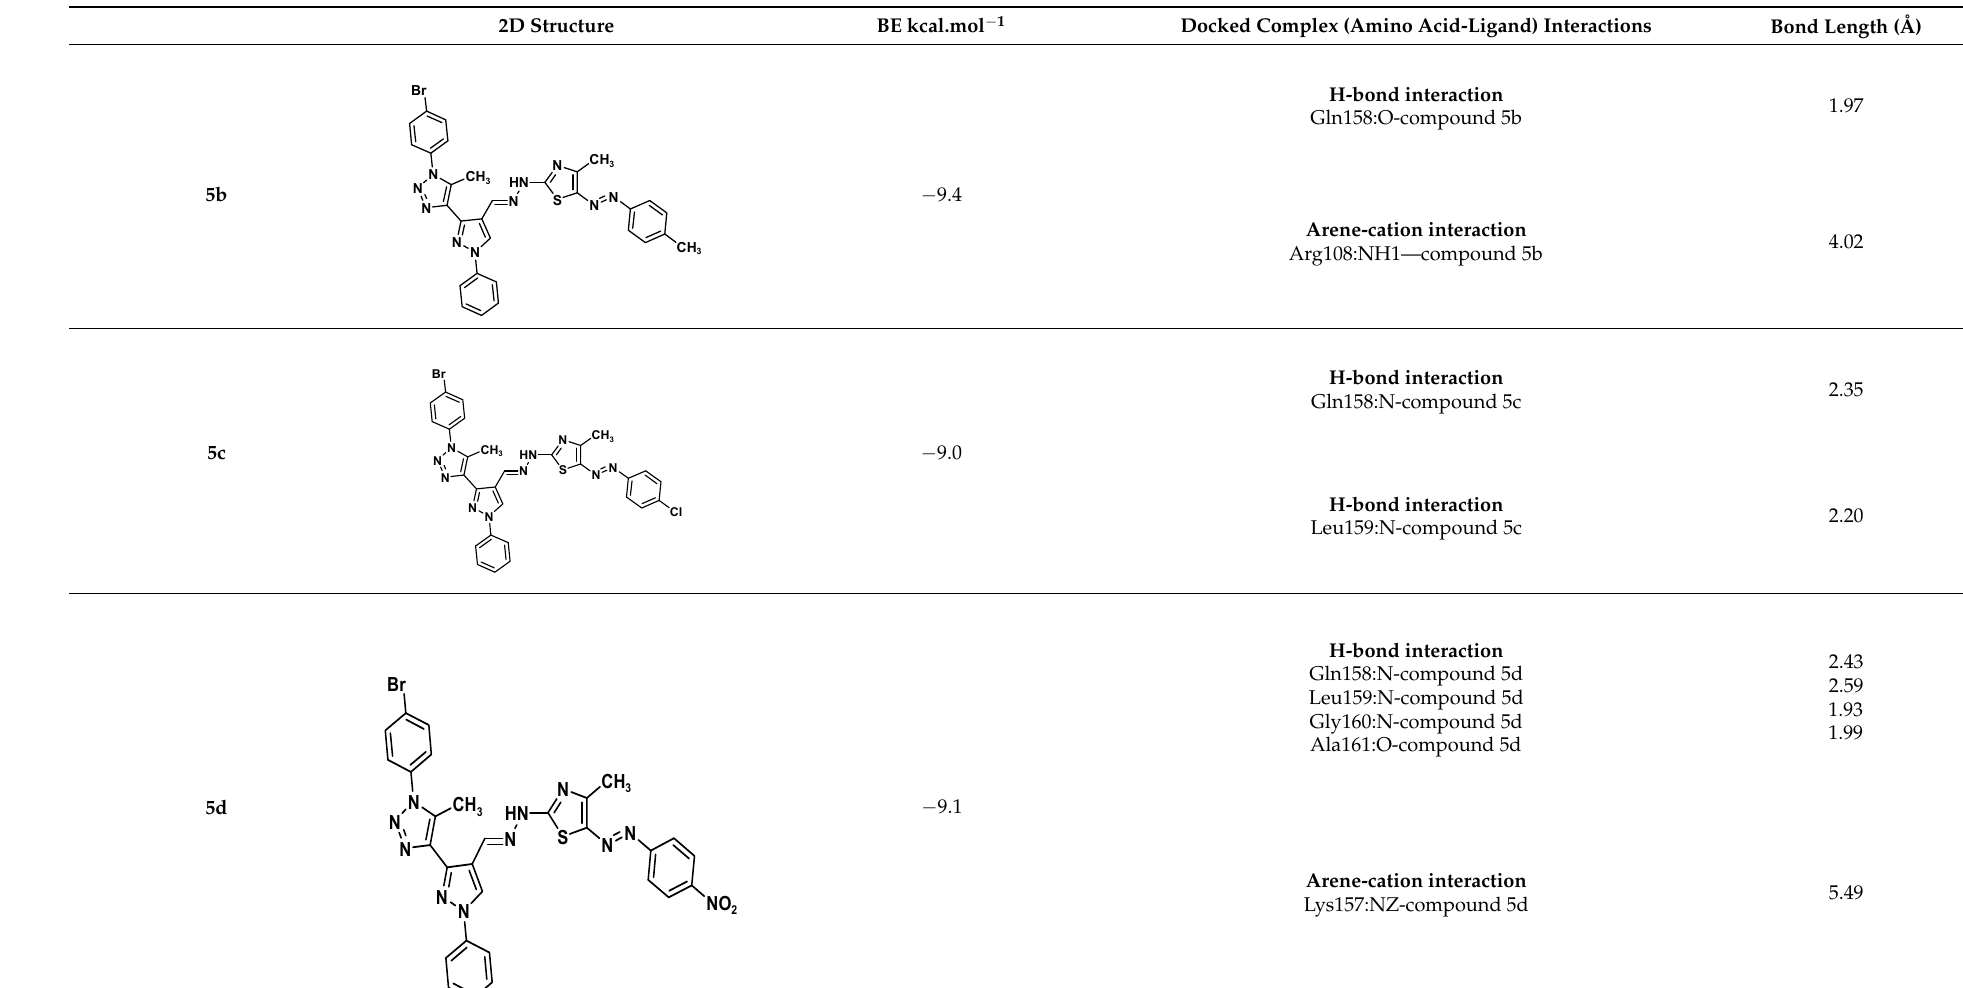
6 of 18 Table 1. Molecular docking results for the screened compounds and Rho6 protein. 2D Structure